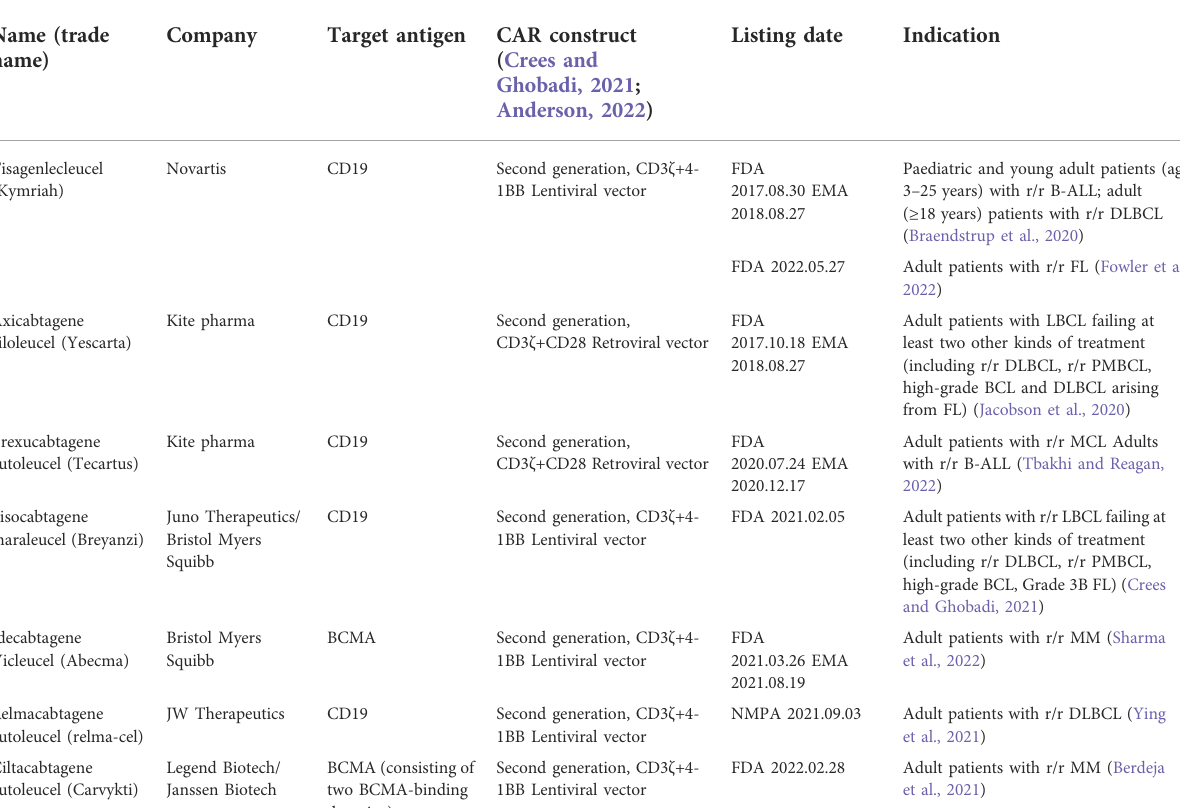
TABLE 1 Approved CAR-T cell